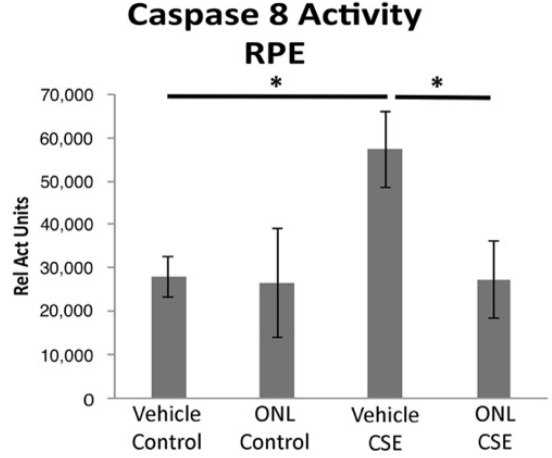
Figure 4. Peptide Fas inhibitor prevents caspase 8 activity in the RPE after cigarette smoke extract exposure. Wild-type mice ( n = 5 per group) were treated with ONL1204 by intravitreal (IVT) injection in one eye and phosphate buffered saline (vehicle control) in the contralateral eye. Three days later, intravenous CSE 1000 µg/mL was given and then again 48 h later. After 3 days, the RPE was extracted to measure caspase 8 activity. The graph shows that caspase 8 activity is increased by CSE relative to control, and this is prevented by ONL1204; * p < 0.05.